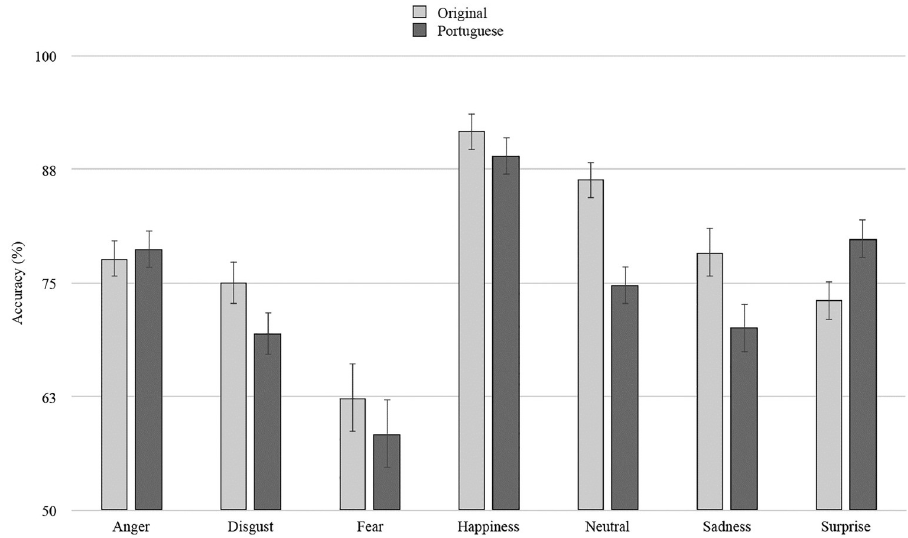
Fig 1. Comparison of mean accuracy rates (%) between samples by facial